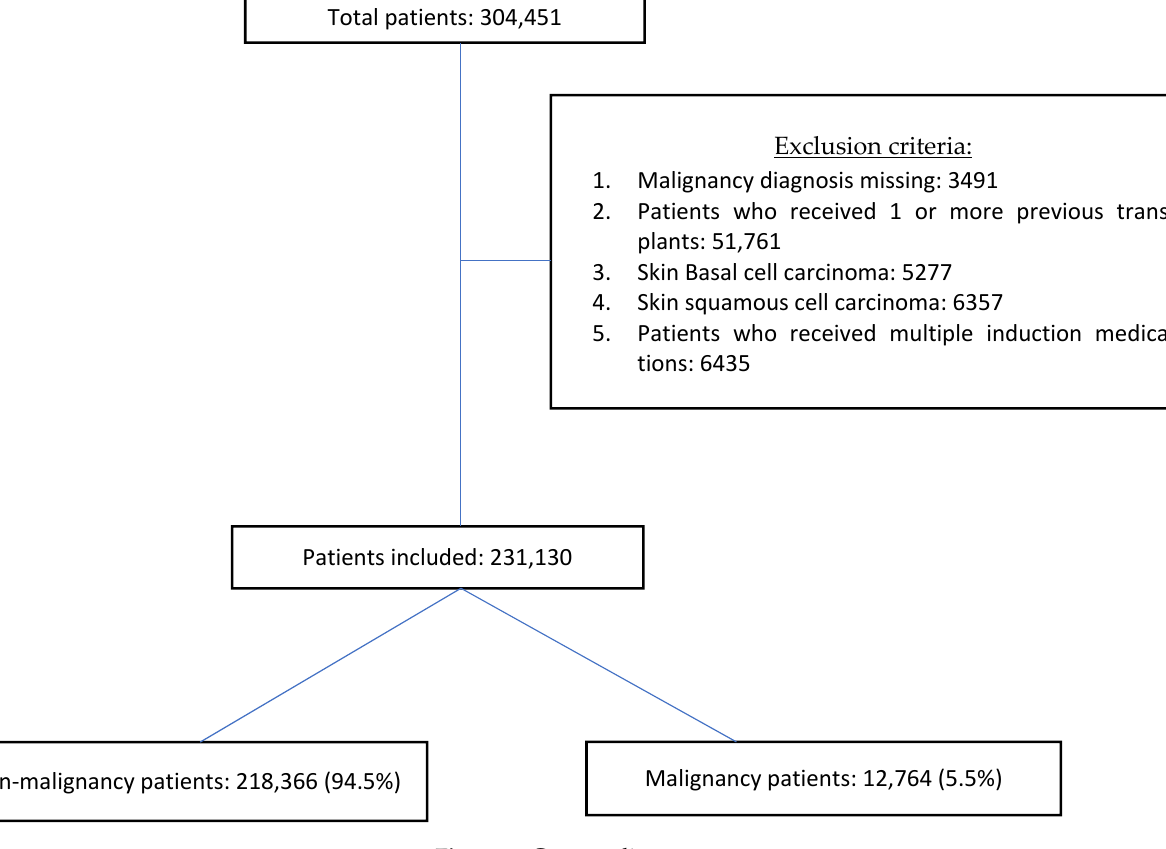
Figure 1. Consort Figure 1. Consort diagram.